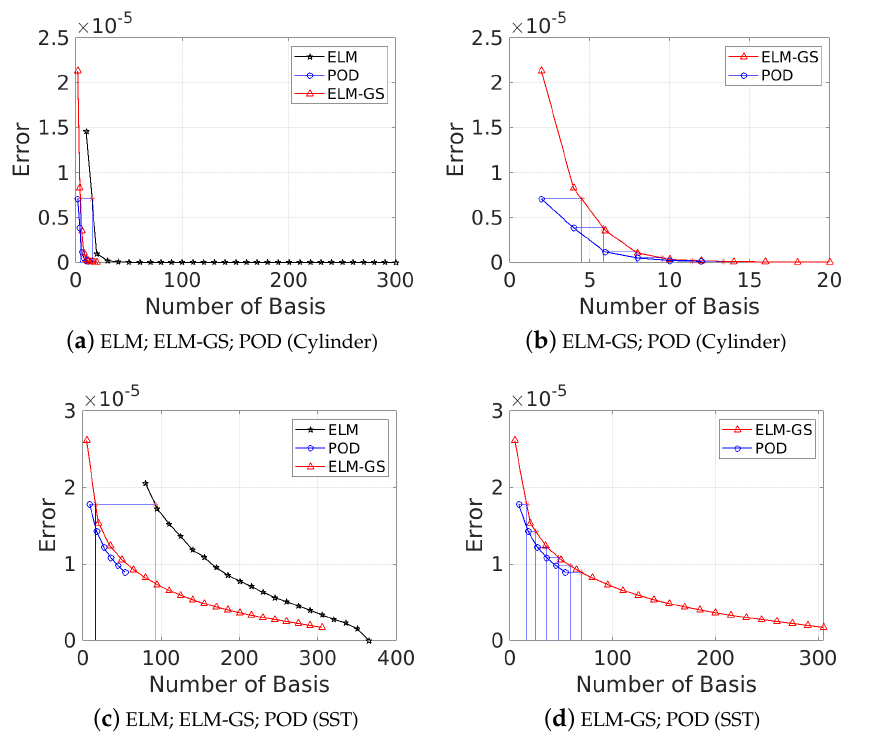
Figure 7. Reconstruction error ( err POD ( K ) for POD, ELM and Gram–Schmidt extreme learning machine (ELM-GS) bases, considering both cylinder wake data (top row) and sea surface temperature (SST) data (bottom